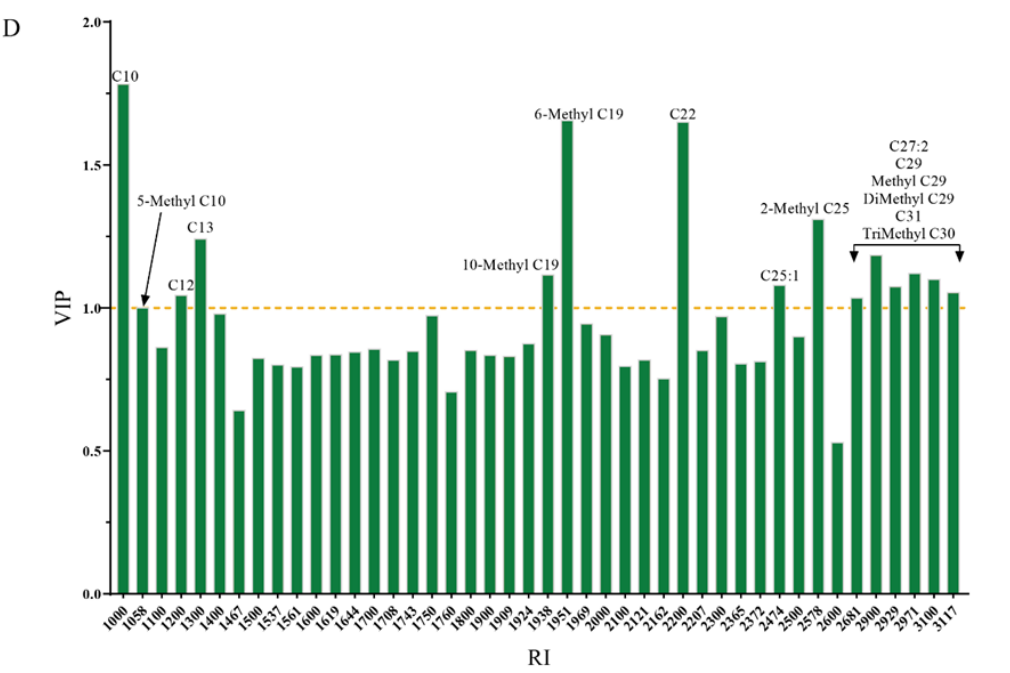
Figure 1. (A ): Total abundance of S. peregrina puparia hydrocarbons in three temperatures (10 °C , 25°C, 40 °C ). ( B ): OPLS − DA of the various compositions of S. peregrina puparia. ( C ): The result of response permutation testing. ( D ): The hydrocarbons with VIP of OPLS − DA model. VIP > 1 regarded the hydrocarbons as significant.